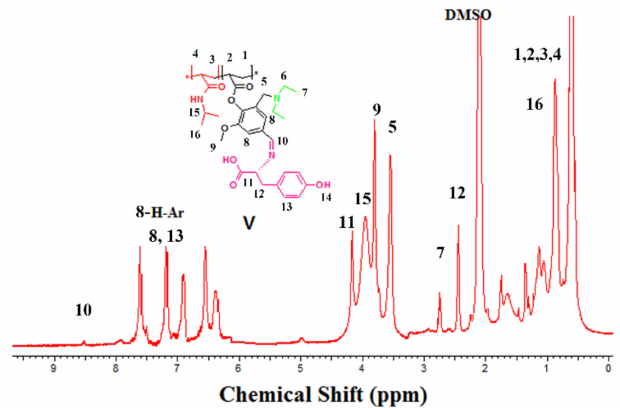
Figure 6. 1 H NMR spectra (CDCL 3 ) of poly(NIPAAm- co -DEAMVA) with 5, 10, and 15% mole ratio of DEAMVA.